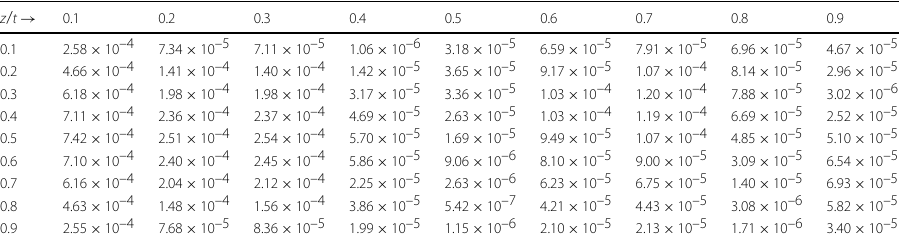
Table 4 Absolute errors for Example 1 by IRKM [31] at t = 1 when α = 0.9, N = 100, and (cid:3) t = 0.001